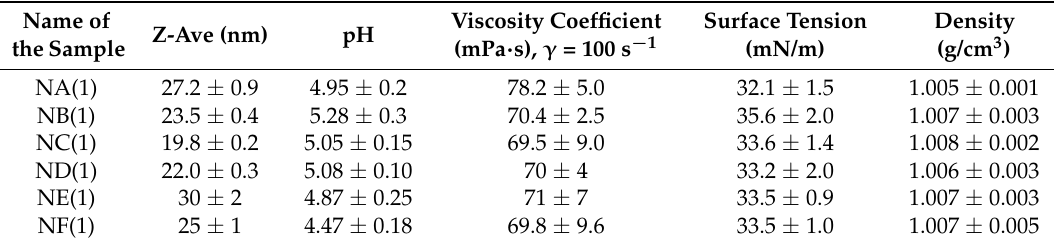
Table 5. Physicochemical properties of nanoemulsions containing different fragrance compositions with an S:O ratio of 0.625:0.375 (SD, n =